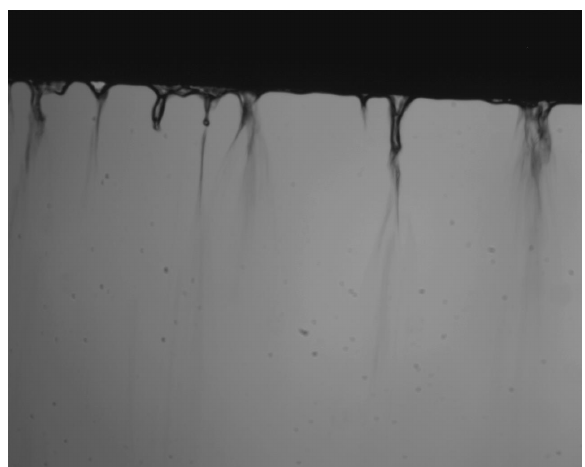
Figure 4. Droplets formation on the trailing edge of the profile in the wind tunnel.